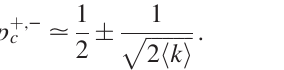
ffiffiffiffiffiffiffiffiffiffiffiffiffi 2 N h k i